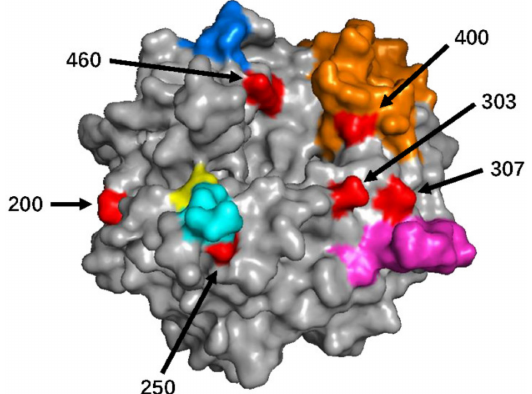
Figure 2. Mapping of the amino acid positions with high variations and positive selection pressure on the structural model of the MeV H protein (PDB number: 2ZB6). The hemagglutinating and neutralizing epitope (HNE), neutralizing epitope (NE), receptor binding epitope (RBE), loop epitope (LE), and sugar-shielded epitope (SSE) are colored in orange, cyan, marine blue, light magenta, and yellow, respectively. Detected amino acid positions with high variations and positive selection pressure are in red (positions 43, 615, and 616 were absent in this